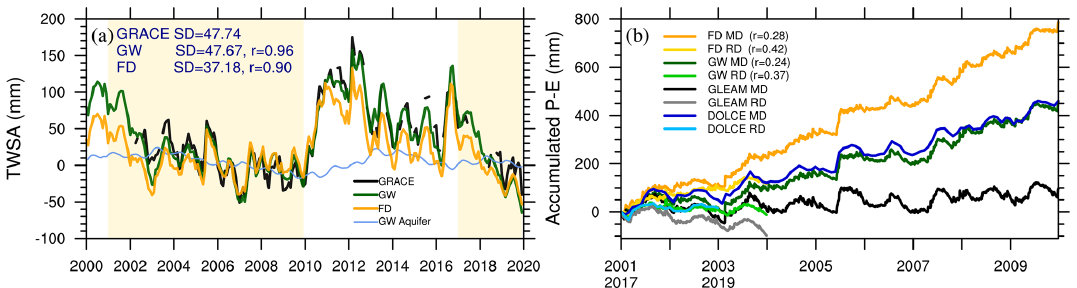
Figure 1. (a) Total water storage anomaly (TWSA) during 2000–2019 and (b) accumulated P – E for the two droughts over SE Australia. In panel (a) , observations from GRACE are shown in black, the GW simulation in green, FD in orange, and the aquifer water storage anomaly in GW in blue. The shading in panel (a) highlights the two drought periods. The left top corner of panel (a) displays the correlation ( r ) between GRACE and GW/FD, as well as the standard deviation (SD,mm) of GRACE, GW, and FD over the periods when GRACE and the simulations coincide. Panel (b) shows the accumulated P – E for two periods; the dark lines show the 2001–2009 Millennium Drought (MD) and the light lines show the 2017–2019 recent drought (RD). The correlation ( r ) between the P and E is shown in the legend of panel (b)